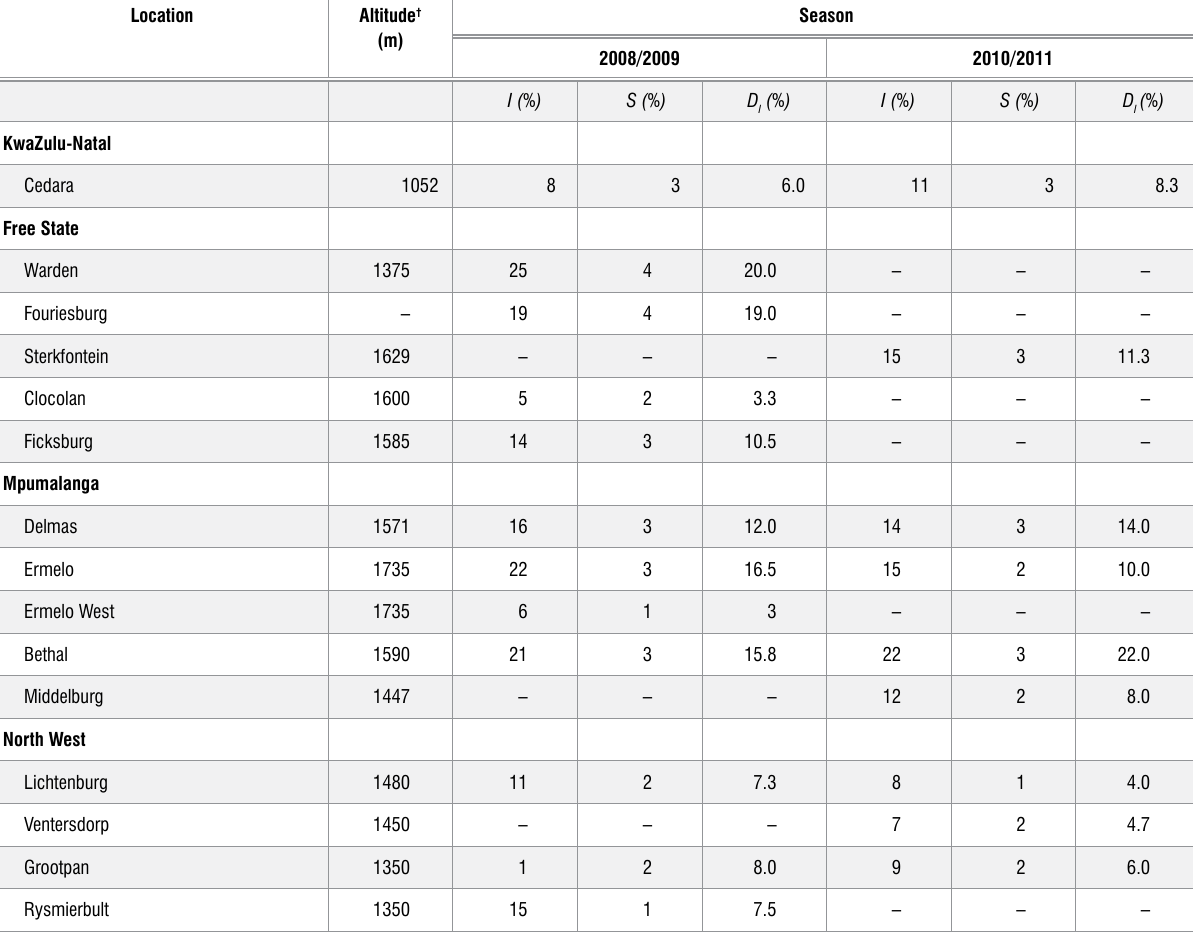
Occurrence of bacterial brown spot in dry bean national cultivar trials of South Africa Location Altitude